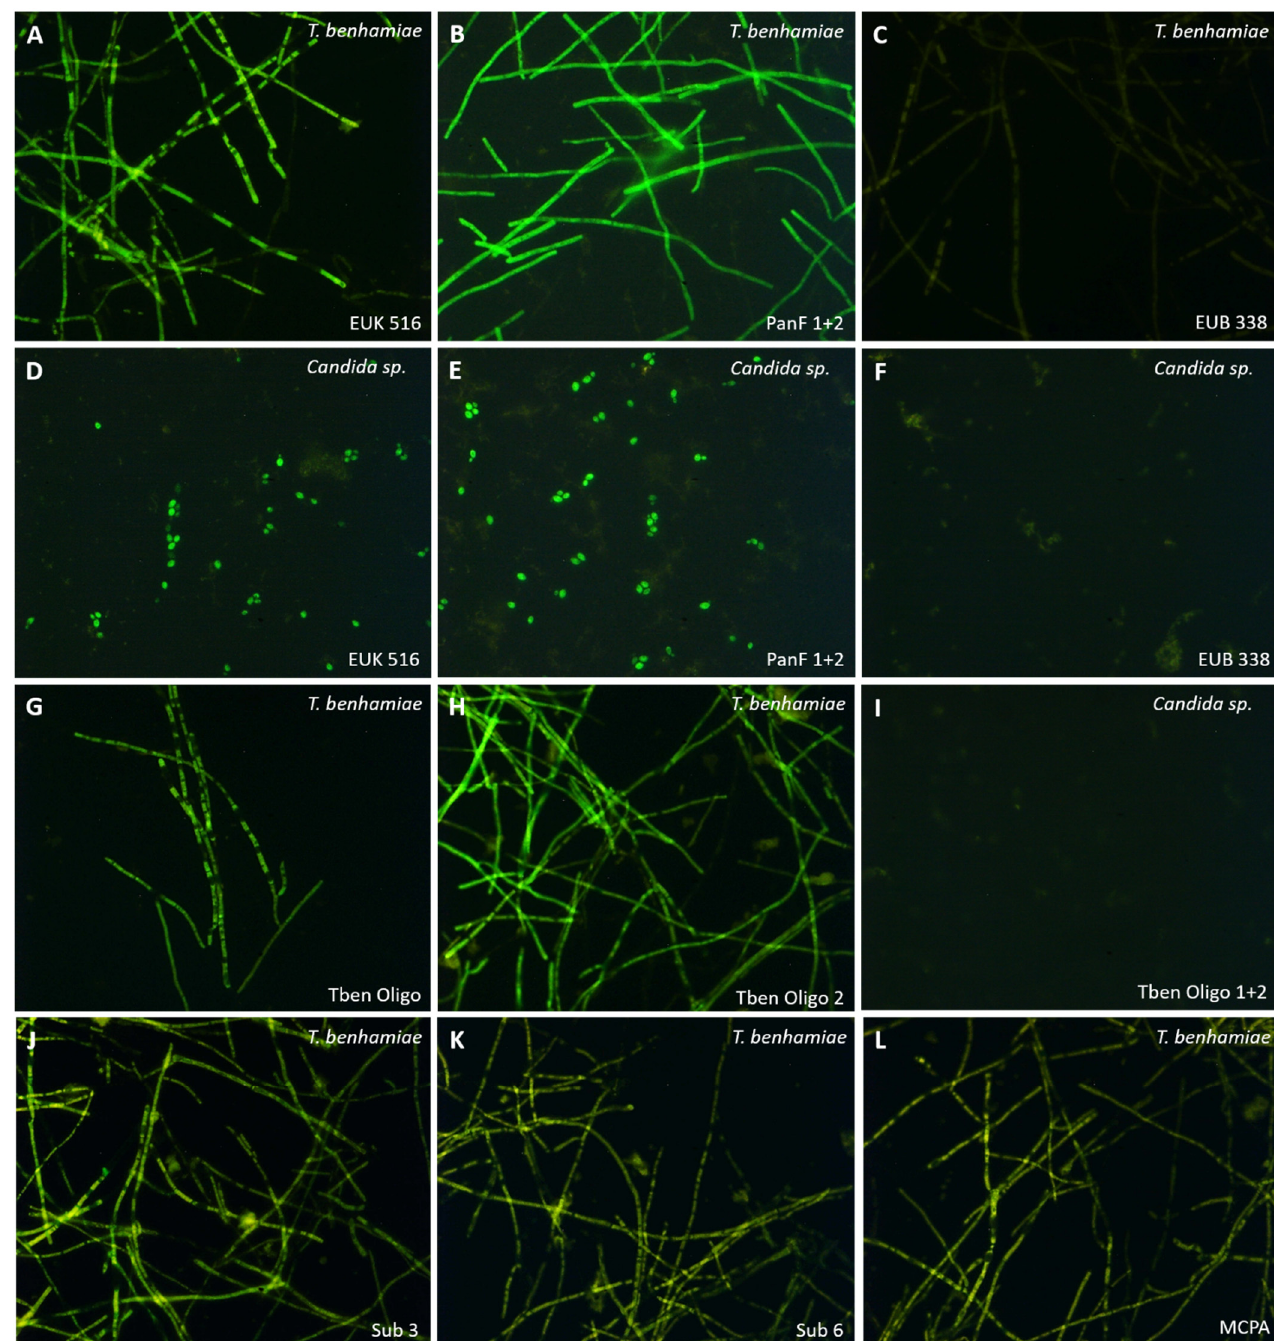
Figure 1. FISH in T. benhamiae isolates and controls ( Candida sp.). The fungal species is indicated in the upper right corner and the used probe/probe mix (all coupled to 6-FAM and shown in green) in the lower right corner of each picture. First and second row ( A – F ): the eukaryote (EUK 516) and the panfungal probes (PanF 1+2) stain positive while the eubacteria probe (EUB 388) stains negative in both fungal species used. Third row ( G – I ): Oligo 1 (Tben) and 2 (Tben) were specifically designed for T. benhamiae; probe specificity is proven by negative staining of Candida sp. The fourth row ( J – L ) shows virulence factor-specific probes staining positive in different T. benhamiae isolates (all images: original magnification 400×).